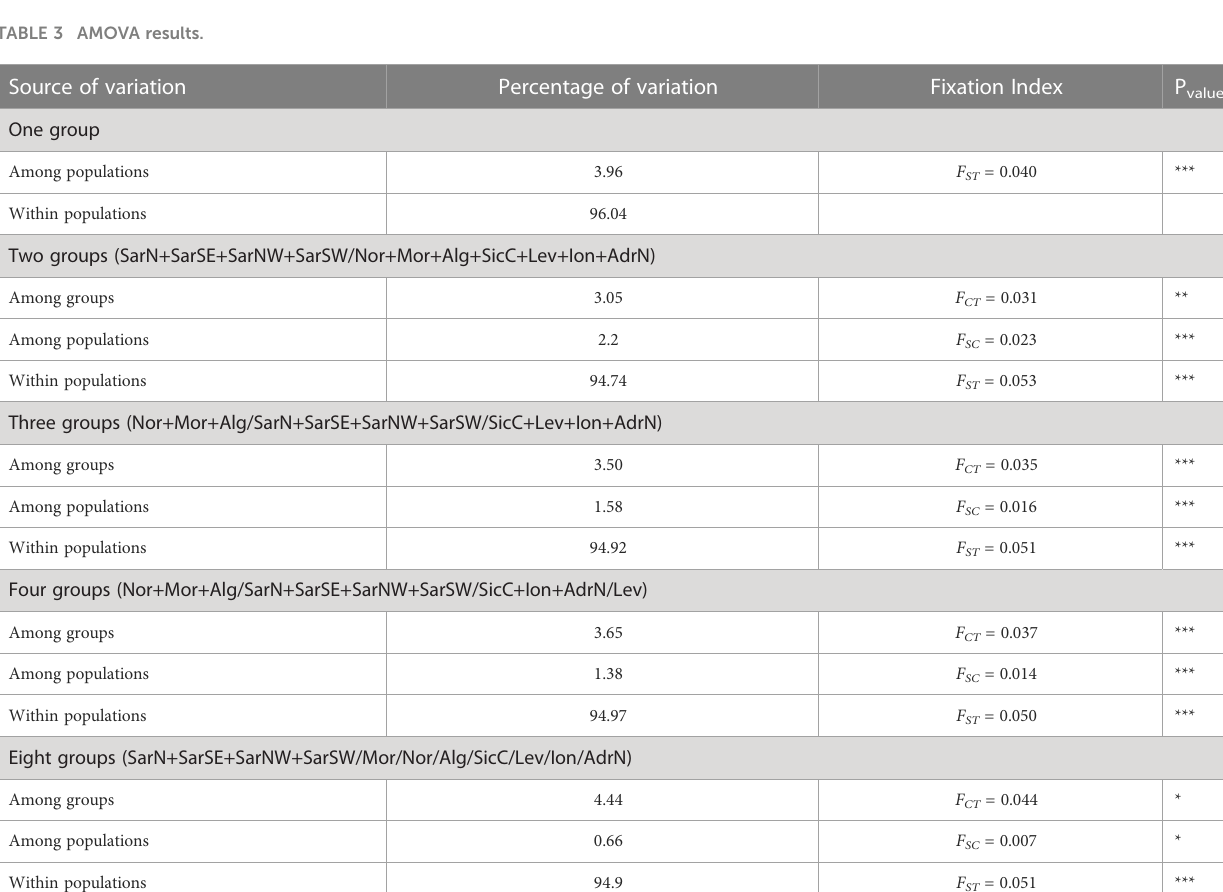
TABLE 3 AMOVA results. Source of variation Percentage of variation Fixation